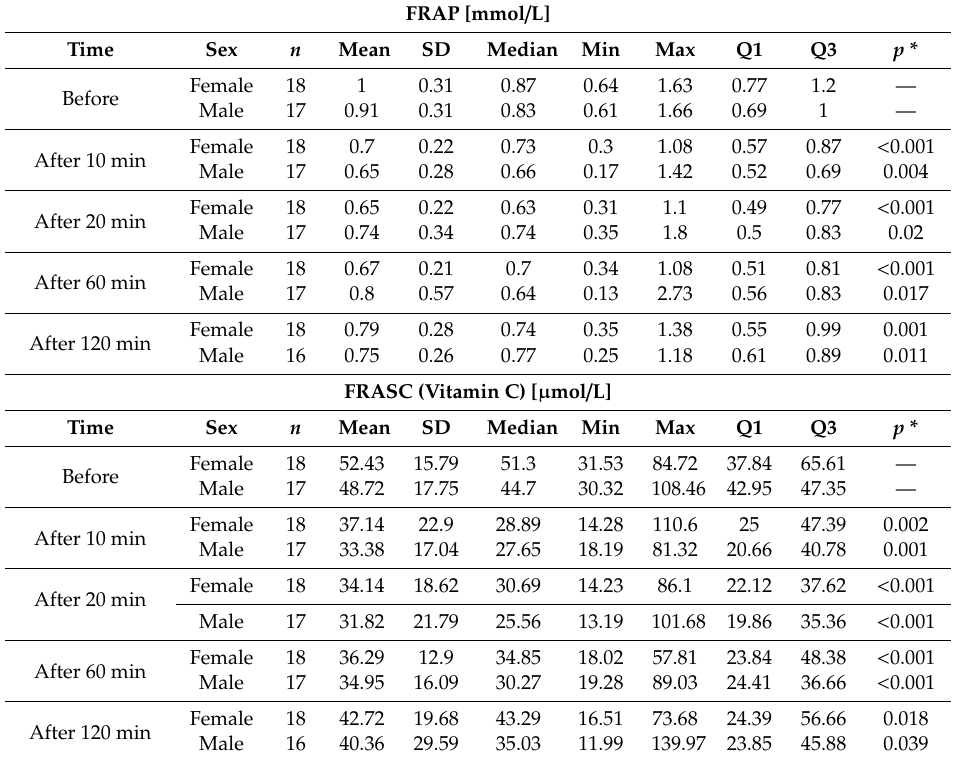
Table 3. Total antioxidant capacity expressed as FRAP (ferric reducing ability of plasma) and FRASC (ferric reducing antioxidant activity and ascorbic acid concentration) in the blood of subjects undergoing routine HRCT examination before the test, 10 min, 20 min, 60 min and 120 min after the test.